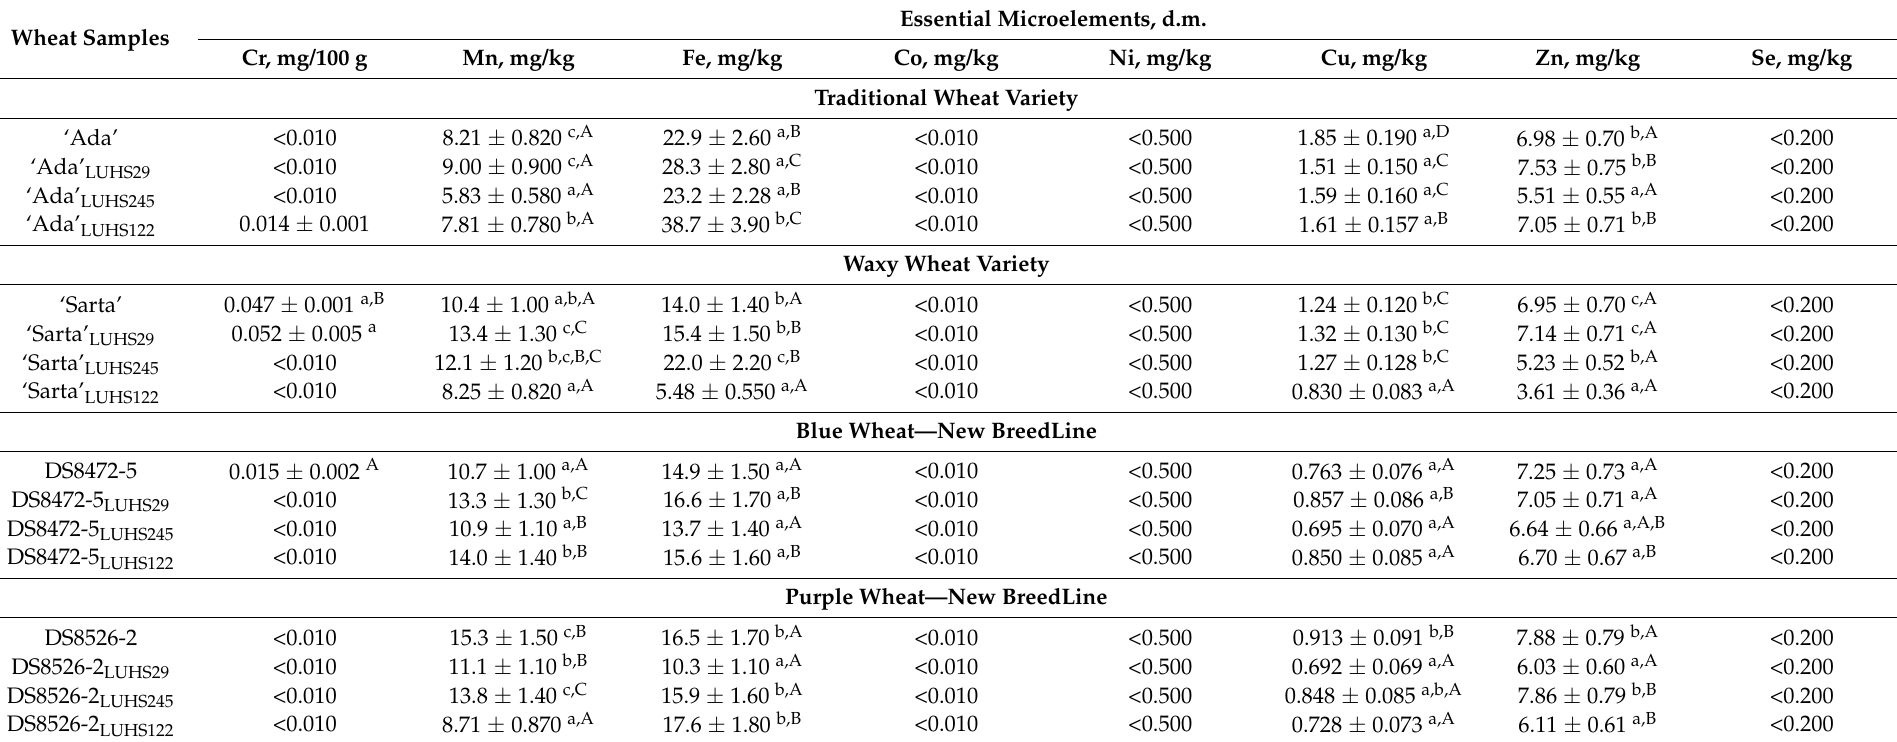
Table 4. Essential microelement concentrations in wheat wholemeal samples. Wheat